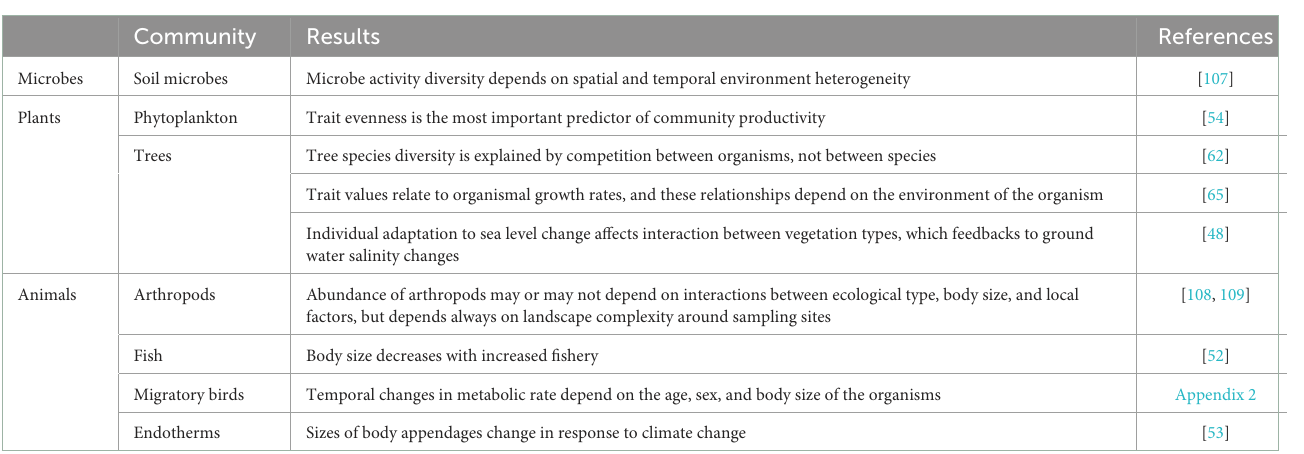
TABLE 2 Examples of empirical organism-based studies of